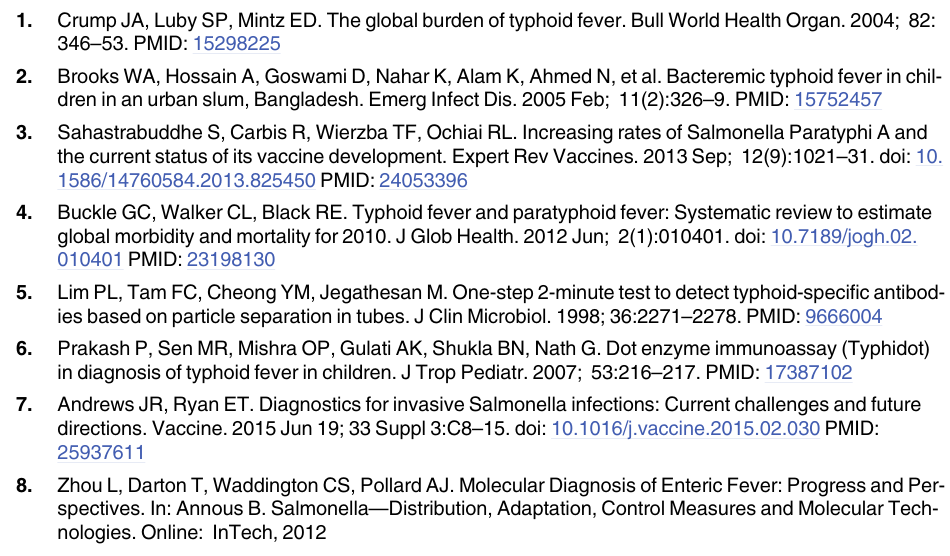
S1 Table. Participants challenged with S. Paratyphi and clinical diagnosis of paratyphoid. S2 Table. Automated blood culture, quantitative blood culture and blood culture PCR assay on the diagnosis day of paratyphoid. S3 Table. Time to positivity of automated blood culture of the samples collected on the diagnosis day of